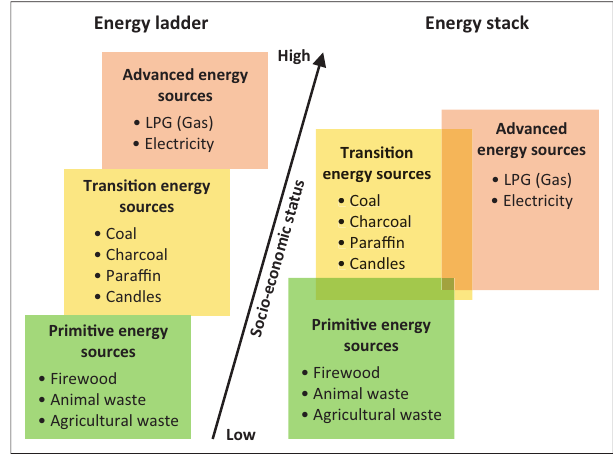
FIGURE 1: Energy transition process: Energy ladder model versus energy stacking